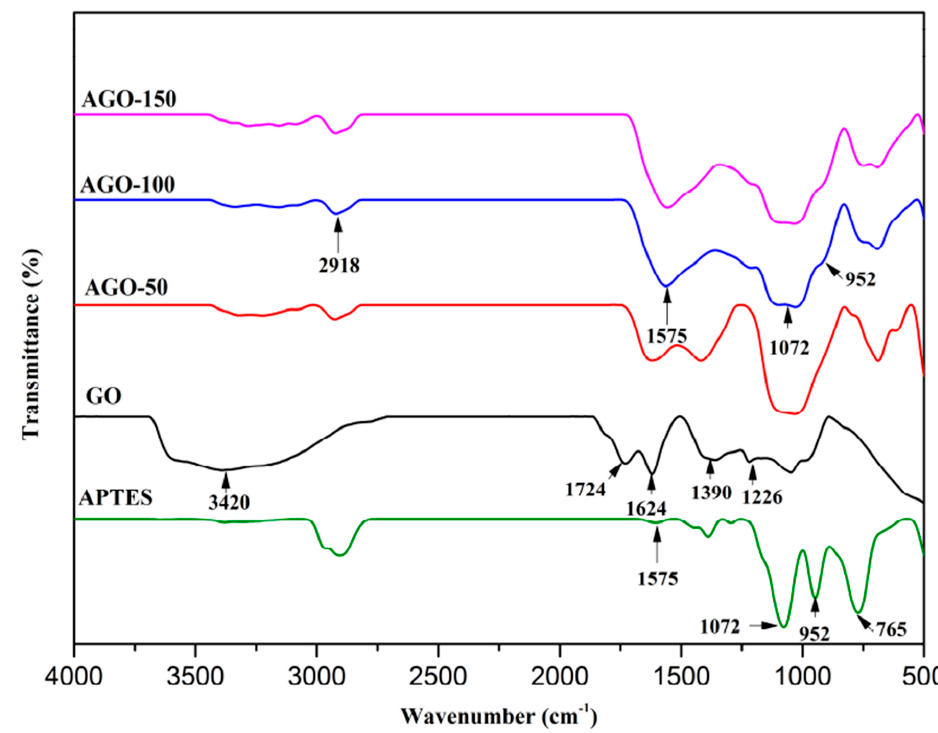
Figure 2. FTIR spectra of GO and 3-aminopropyltriethoxysilne functionalized-GO (AGO-50, AGO-100 and AGO-150). Int. J. Mol. Sci. 2019 , 20 , x FOR PEER REVIEW